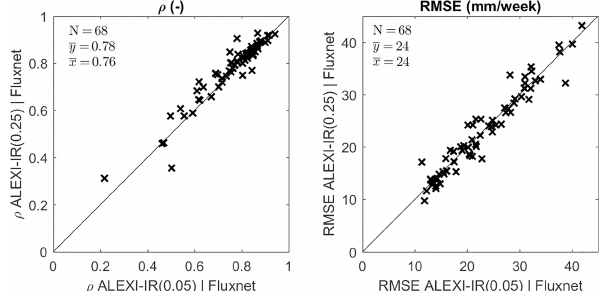
Figure 10. The effect of spatial resolution in the satellite product on Pearson correlation ( ρ ) and RMSE between weekly ET estimates from satellite data (ALEXI-IR) and flux-tower eddy-covariance measurements (Fluxnet). Each marker represents a single station and compares results at the original 0.05 ◦ resolution of ALEXI- IR ( x axis) with those calculated for 0.25 ◦ resolution ALEXI-IR ( y